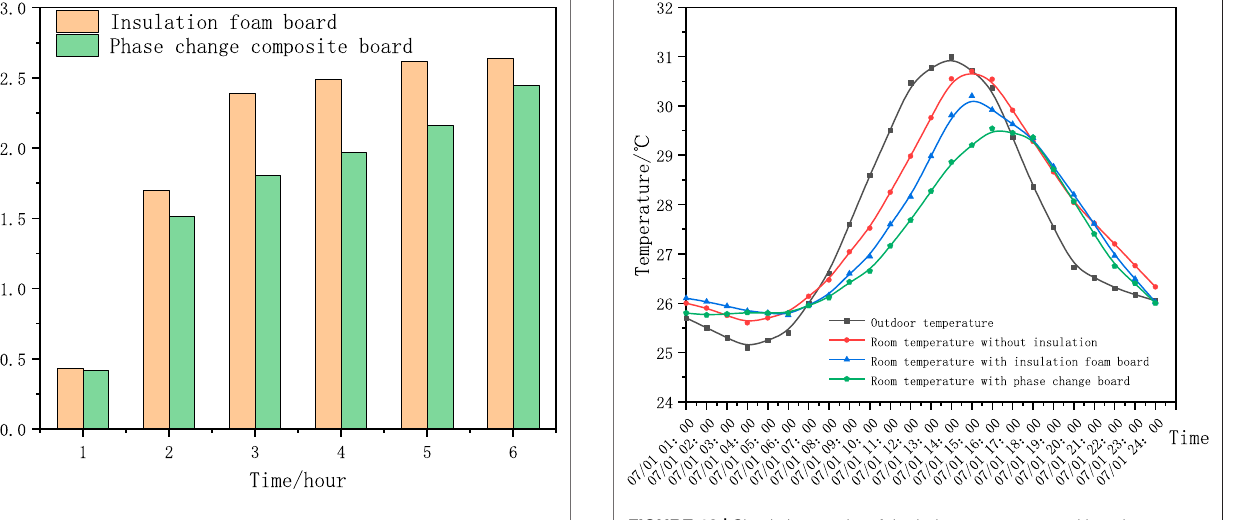
FIGURE17| Hourlycoolingloadofthebuildingmodelswithandwithout phase change.